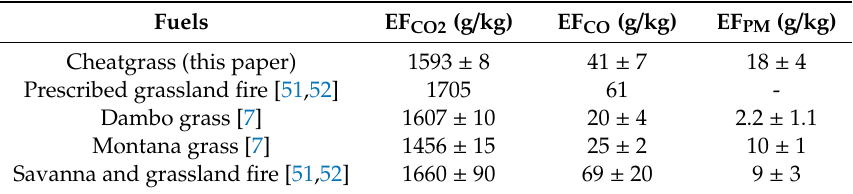
Table 3. EFs (emission factors) for cheatgrass are listed with previously reported data from a prescribed grassland fire [51,52], open combustion of Dambo and Montana grass [7], and savanna and grassland fire [51,52]. Our reported cheatgrass EFs of CO and CO 2 showed good agreement (within 1% and ~6%) with reported EFs of other fuels, while the cheatgrass particulate matter (PM) EFs were ~2.5 times larger than the average of the other three EFs. Fuels EF CO2 (g / kg) EF CO (g / kg) EF PM (g / kg) Cheatgrass (this paper) 1593 ± 8 41 ± 7 18 ± 4 Prescribed grassland fire [51,52] 1705 61 - Dambo grass [7] 1607 ± 10 20 ± 4 2.2 ± 1.1 Montana grass [7] 1456 ± 15 25 ± 2 10 ± 1 Savanna and grassland fire [51,52] 1660 ± 90 69 ± 20 9 ±